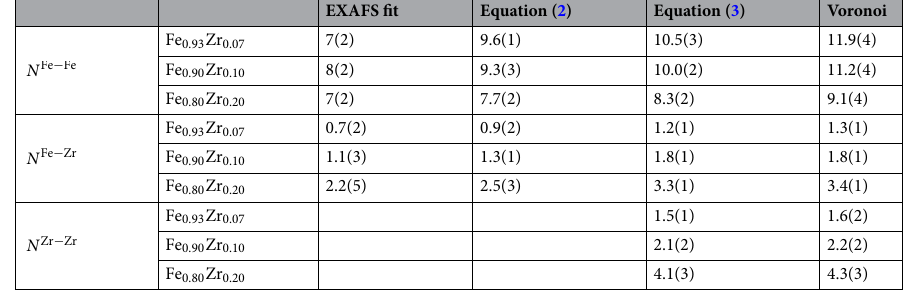
Table 6. Nearest-neighbour coordination numbers obtained from the fitting of the EXAFS data and from the simulated structures. The coordination numbers of the simulated structures are calculated in three different A − B N A − B ways: by summing N 1 and 2 calculated from Eq. (2), from Eq. (3), and from a Voronoi analysis. Details about the distribution of Voronoi coordination numbers are presented in Fig. S4 in the Supplementary